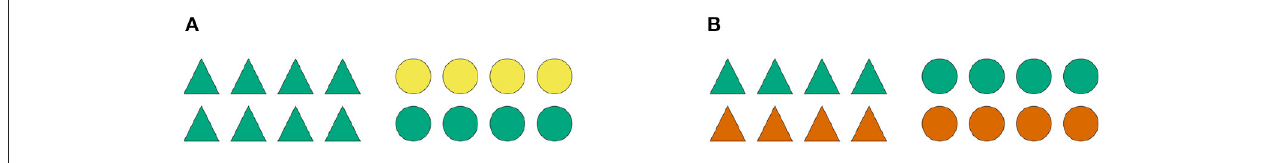
FIGURE 4 | Biased (A) and unbiased (B) scenarios for descriptions containing the quantifier einige